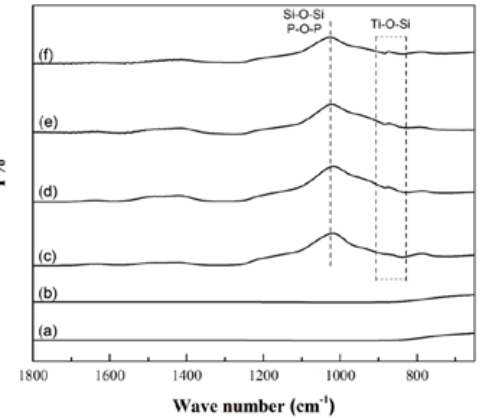
Figure 4. FTIR patterns of (a) SLA Ti, (b) Oxide Ti, (c) MBG–coated Ti, (d) MBG–Ag1–coated Ti, (e)